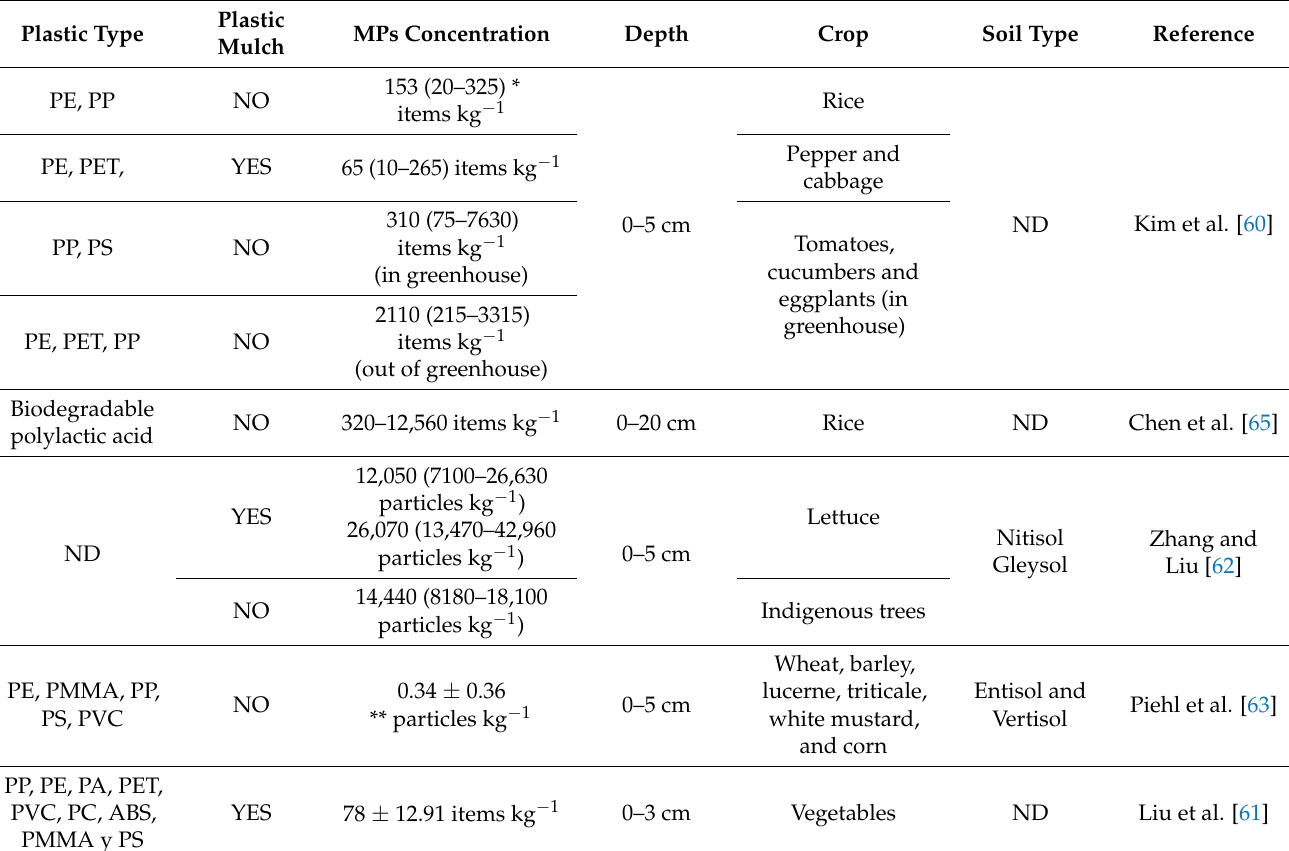
Table 3. Previous investigations quantifying microplastics in